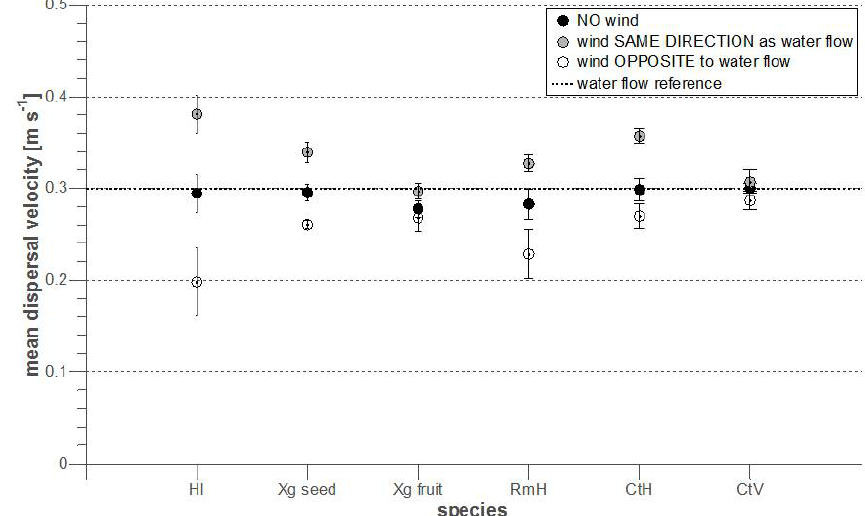
Fig. 3. Mean dispersal velocities for all species used in the flume study, for the N-scenario (black circles), the S-scenario (grey circles) and the O- scenario (open circles). Vertical bars indicate standard deviations. The water flow velocity is added as a reference (dotted line). Hl: Heritiera littoralis propagules; Xg seed and fruit: seed and fruit of Xylocarpus granatum , respectively; RmH: Rhizophora mucronata propagules; CtH and CtV: horizontally and vertically floating Ceriops tagal propagules, respectively.